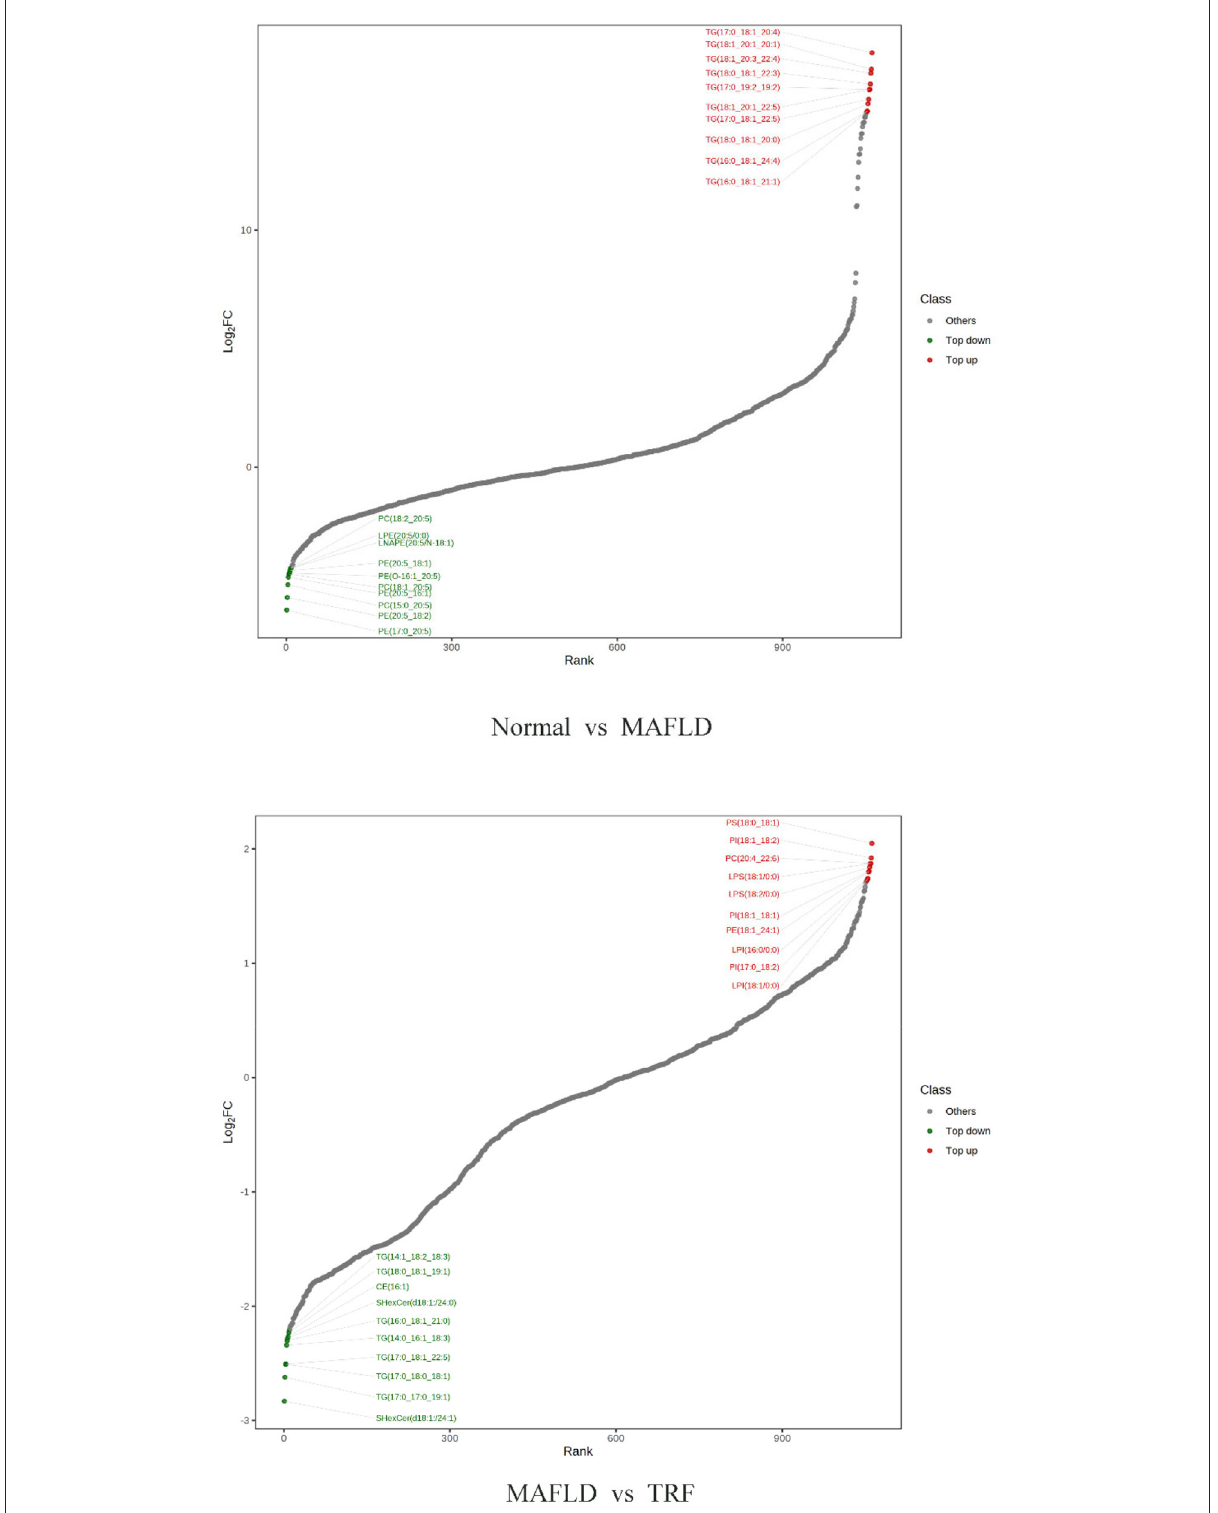
FIGURE8 Ten differential metabolites with the most significant upregulation and downregulation in liver tissue. Normal, rats fed a normal diet ad libitum ; MAFLD (metabolic associated fatty liver disease), rats fed a high-fat diet ad libitum ; TRF (time-restricted feeding), rats fed high-fat diet (60 kcal% fat) strictly between 16:00 and 22:00 every